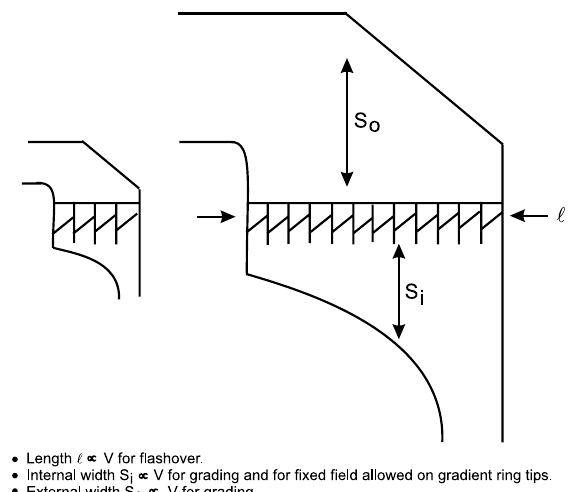
FIG. 12. Inductance of insulator stack of fixed radius scales as V 2